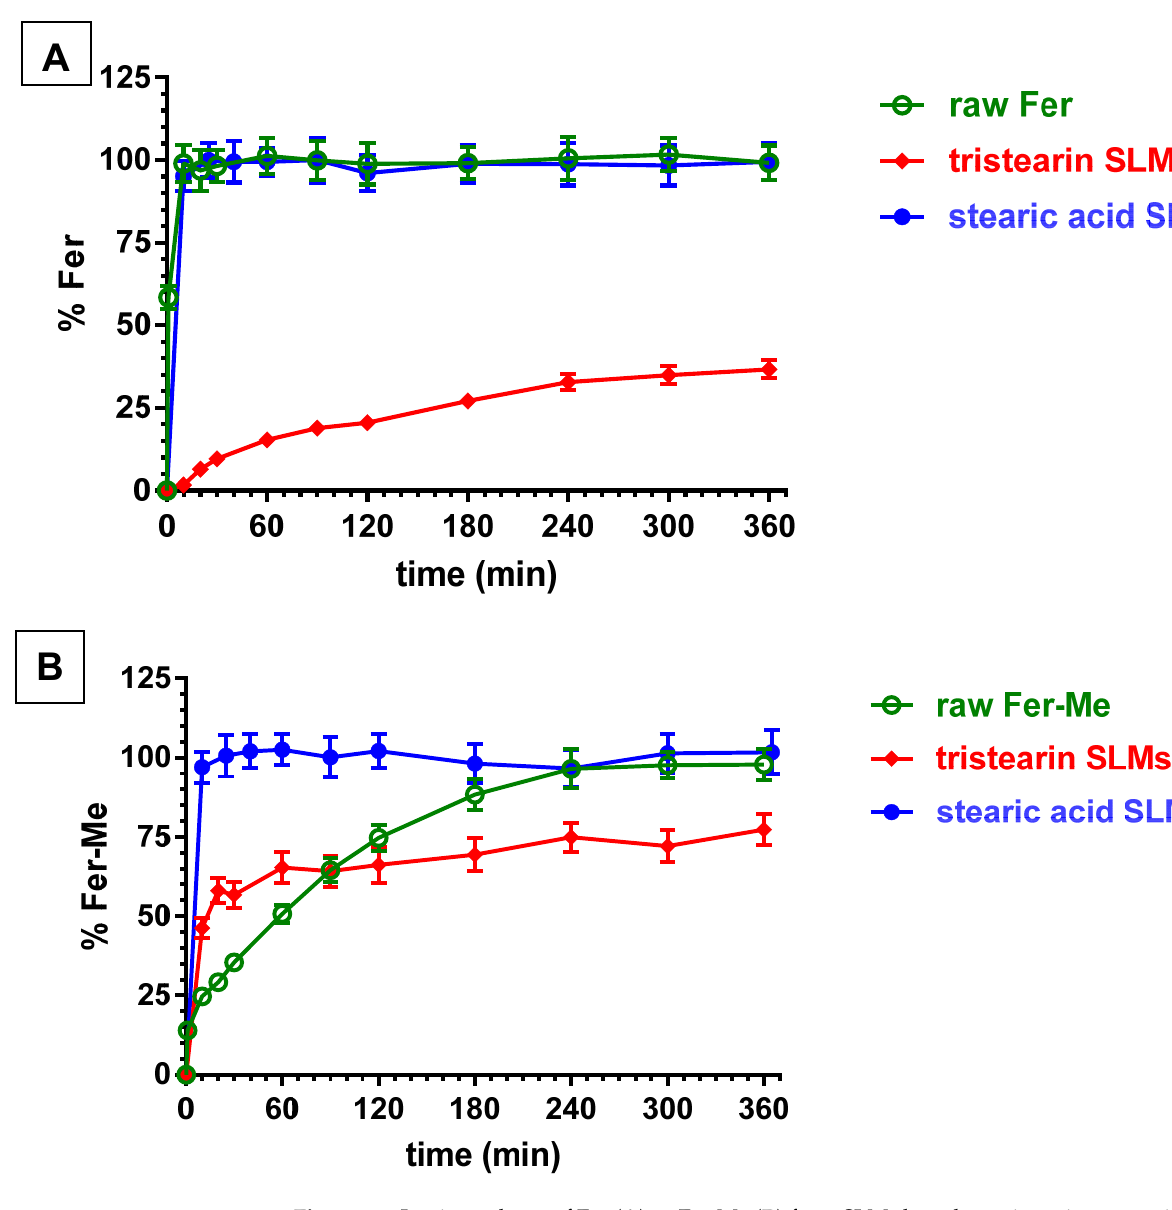
Figure 10. In vitro release of Fer ( A ) or Fer-Me ( B ) from SLMs based on tristearin or stearic acid. The release profiles are compared with those of the raw powder dissolution of the compounds during time. Results are reported as the mean ± S.E.M of four independent experiments.